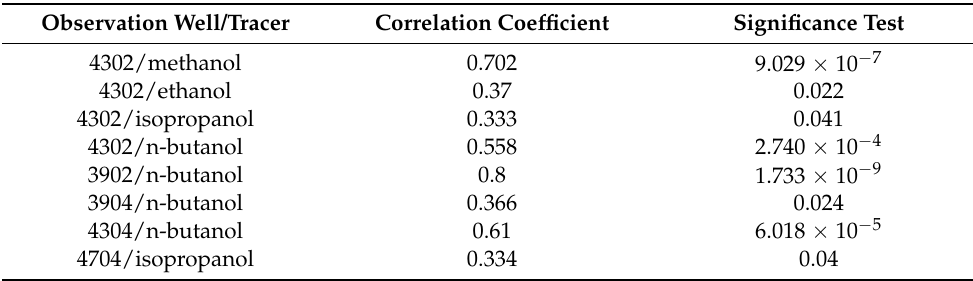
Table 1. Correlation coefficient and error between the calculated value of tracer concentration and the observed value in each observation well.